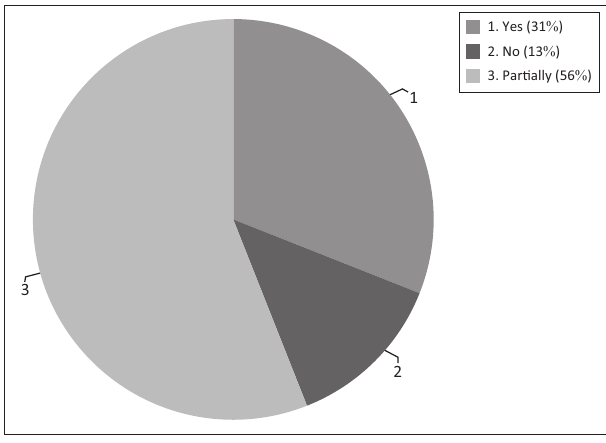
FIGURE 1: The implementation of Basel II and Basel III by participants of the interest groups.